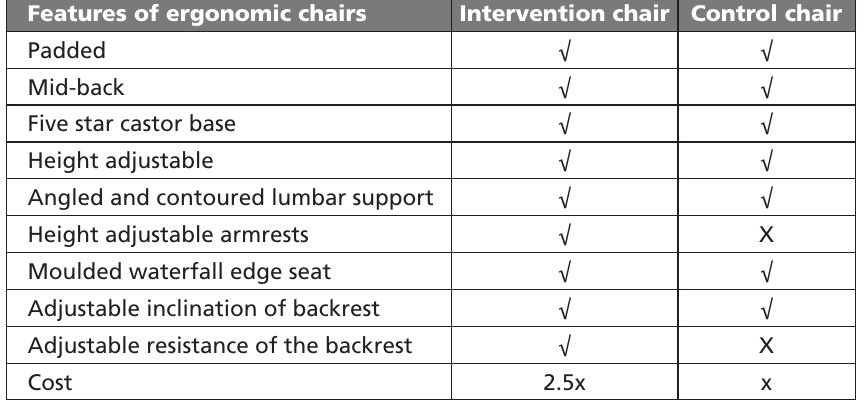
Table 1: Features of the intervention and control ergonomic chairs as used in the